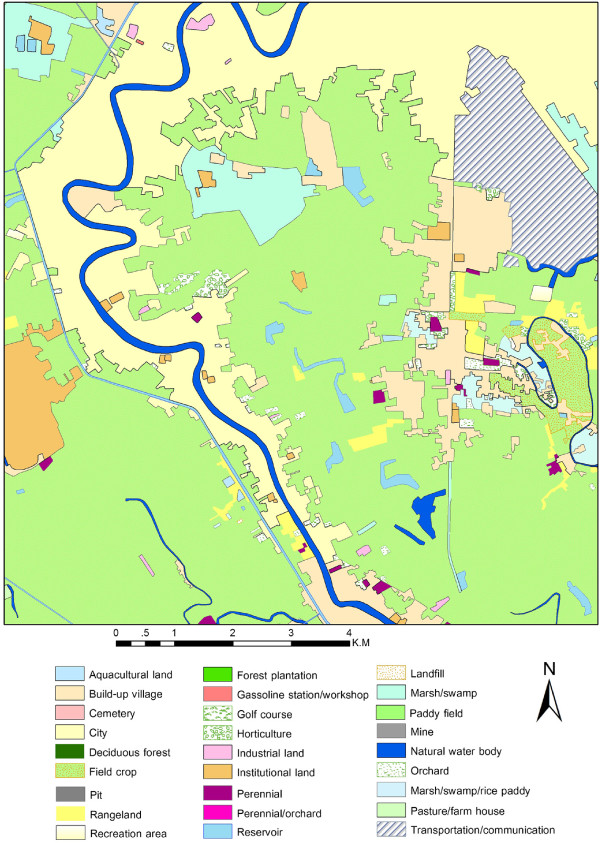
Land-use/land-cover map showing the land-cover types.